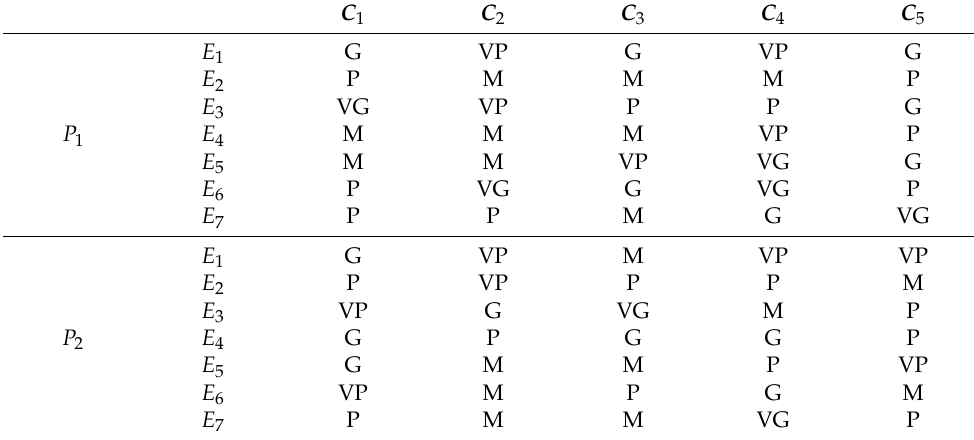
Table 3. Performance ratings of